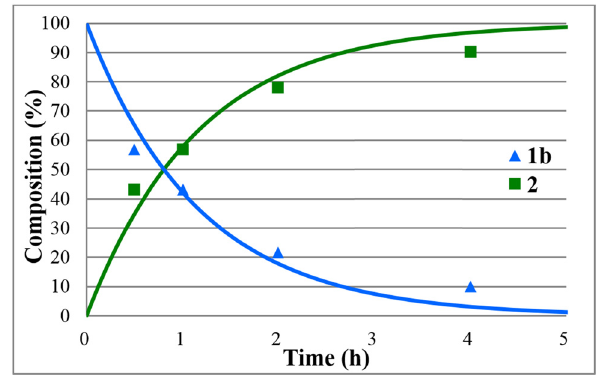
Figure 7: Concentration pro fi le for the components ( 1b and 2 ) during the hydrolysis of ethyl diphenylphosphinate ( 1b ) under MW conditions at 160°C. The R 2 measure of goodness of fi t is 0.903.